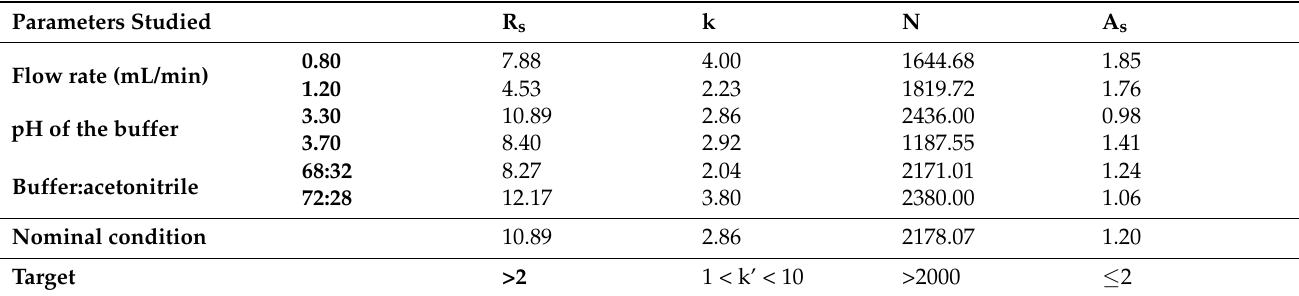
Table 5. Results of the robustness showing the effect of making small changes in the composition, pH and flow rate. Parameters